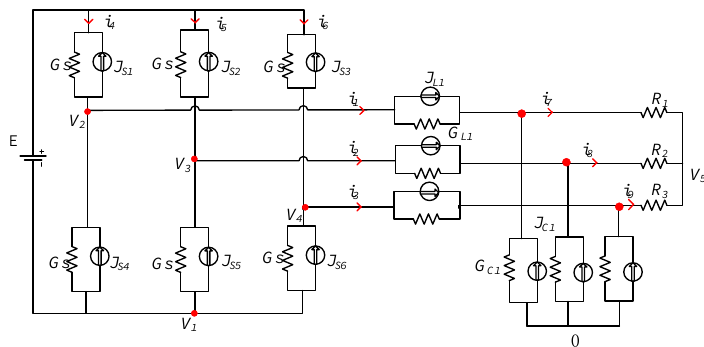
Figure 4. Equivalent circuit of the three-phase inverter. Table 1. System parameter.